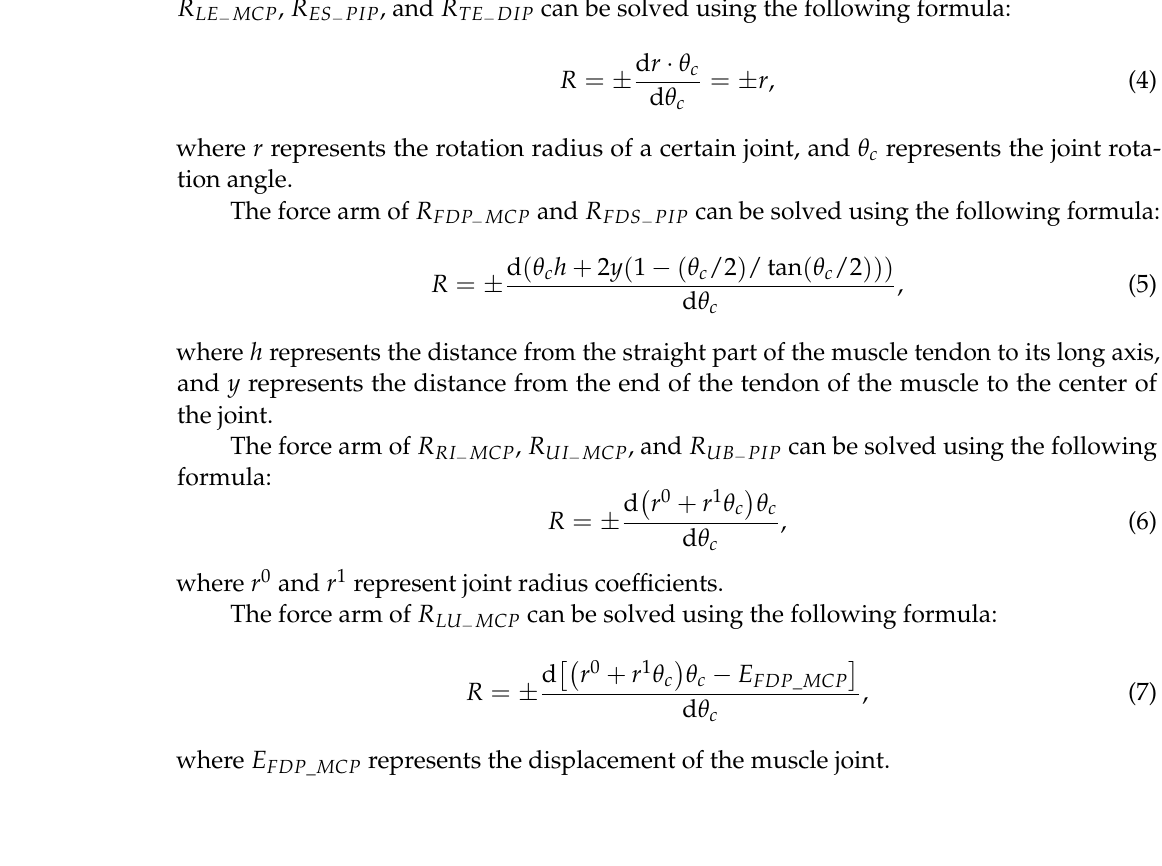
Figure 9. Finger biomechanical relationship.